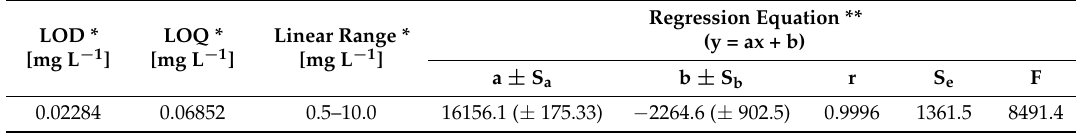
Table 3. The linear regression parameters obtained for the calibration curves of iodide ions.